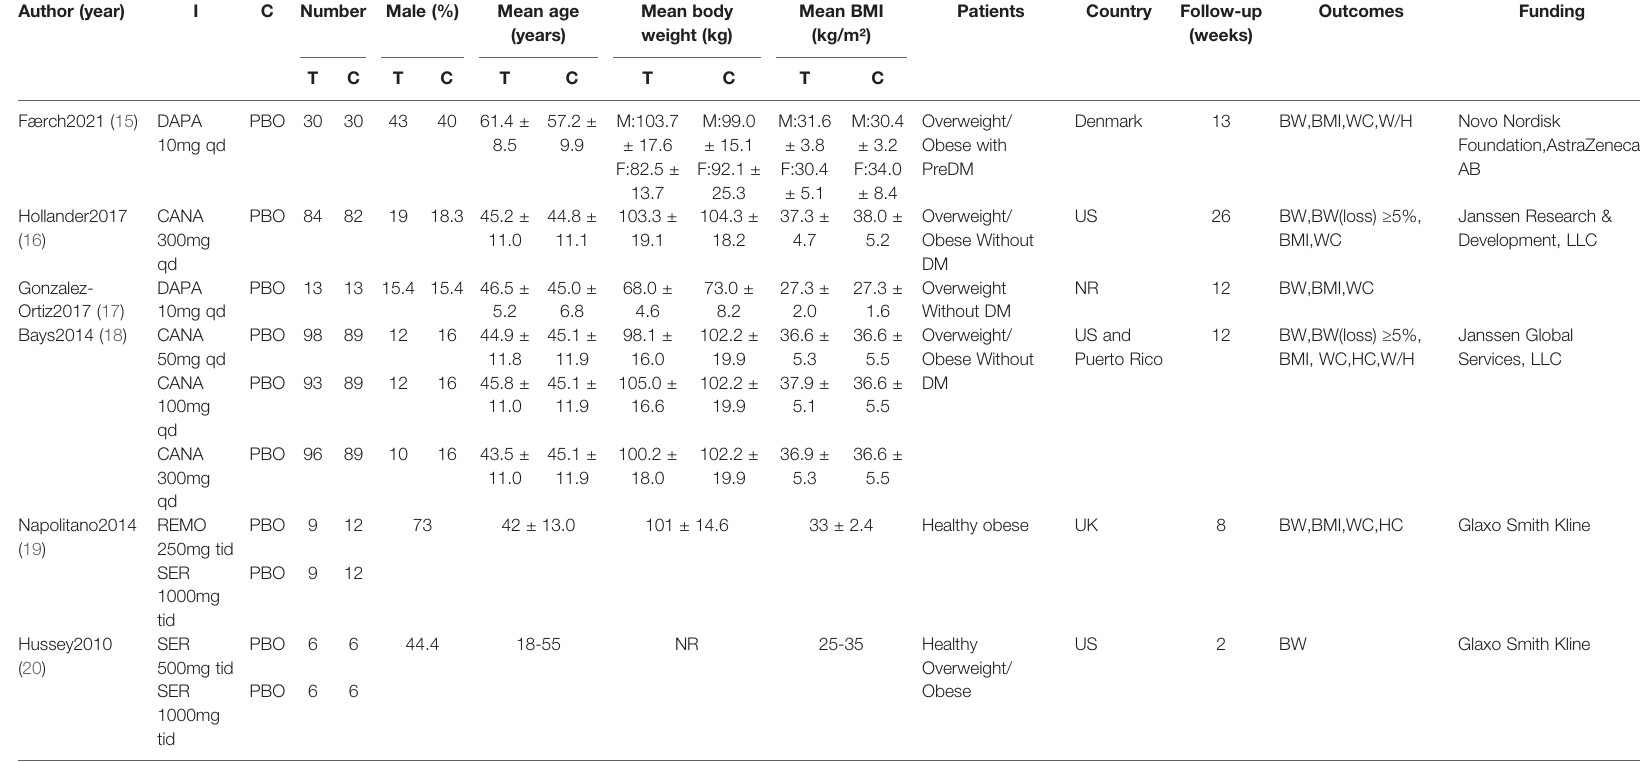
TABLE 1 | Baseline characteristics of each included study